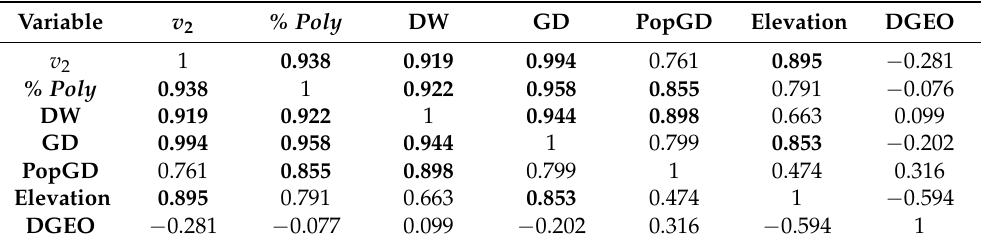
Table 6. Correlations between genetic and geographical variants of Pinus herrerae and the different peripheral and central populations of this